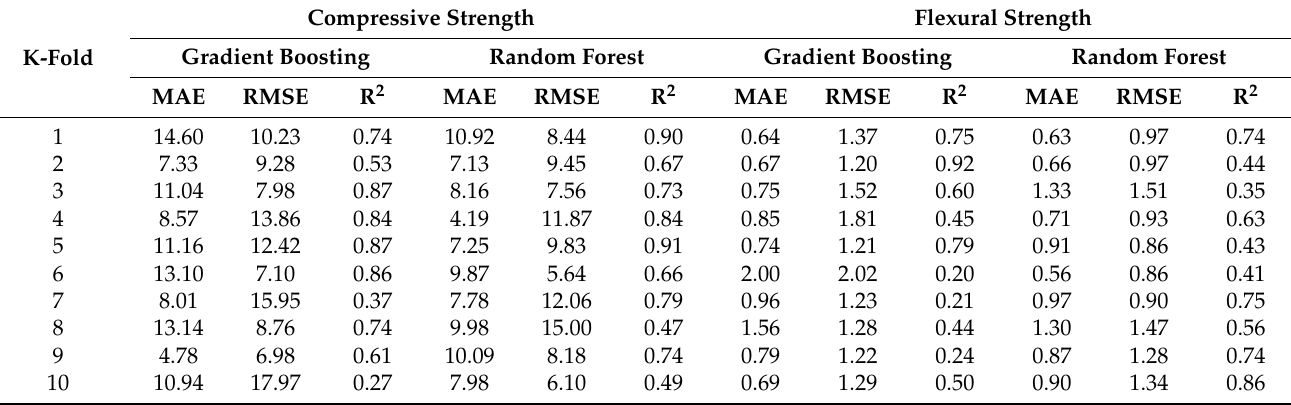
Table 4. Results of k-fold analysis.